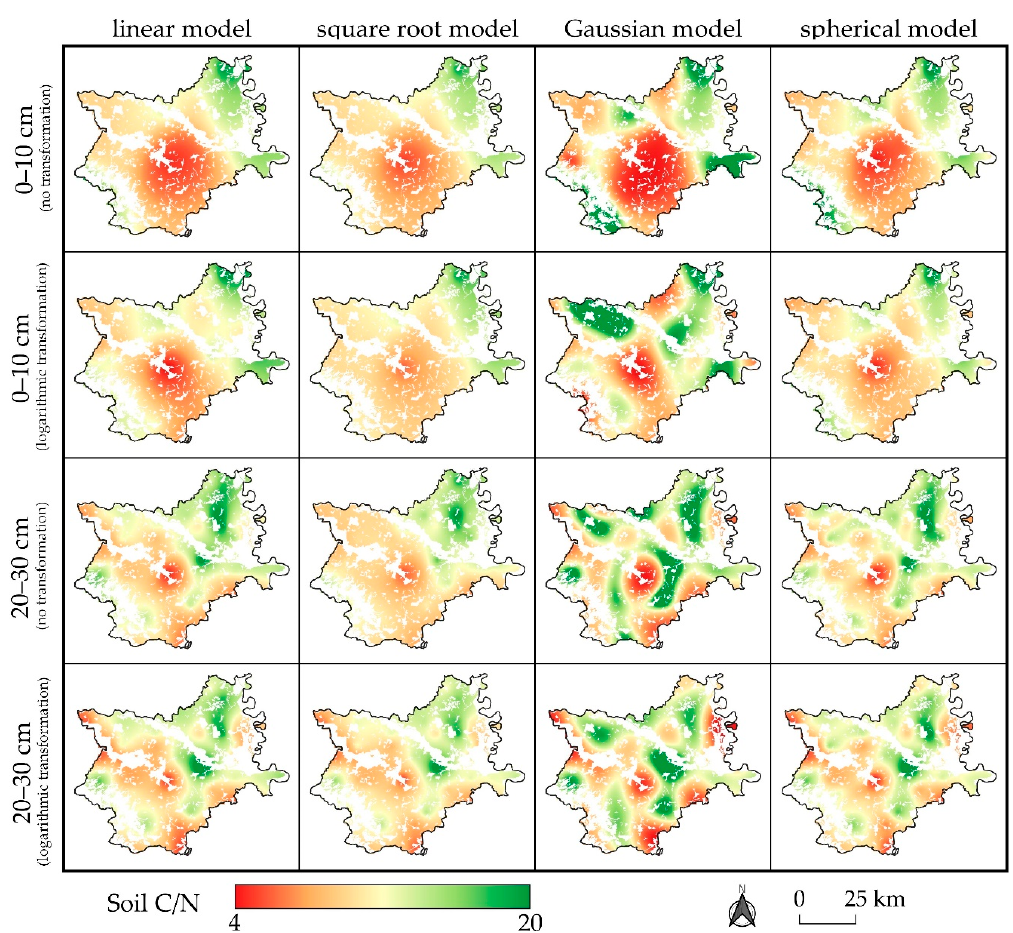
Figure 5. Soil carbon-to-nitrogen ratio (C / N) maps calculated using various interpolation parameters. The soil C / N balance per major crops was evaluated according to the values displayed in Figure 5. Table 5. Descriptive statistics of the final soil C/N interpolation results.